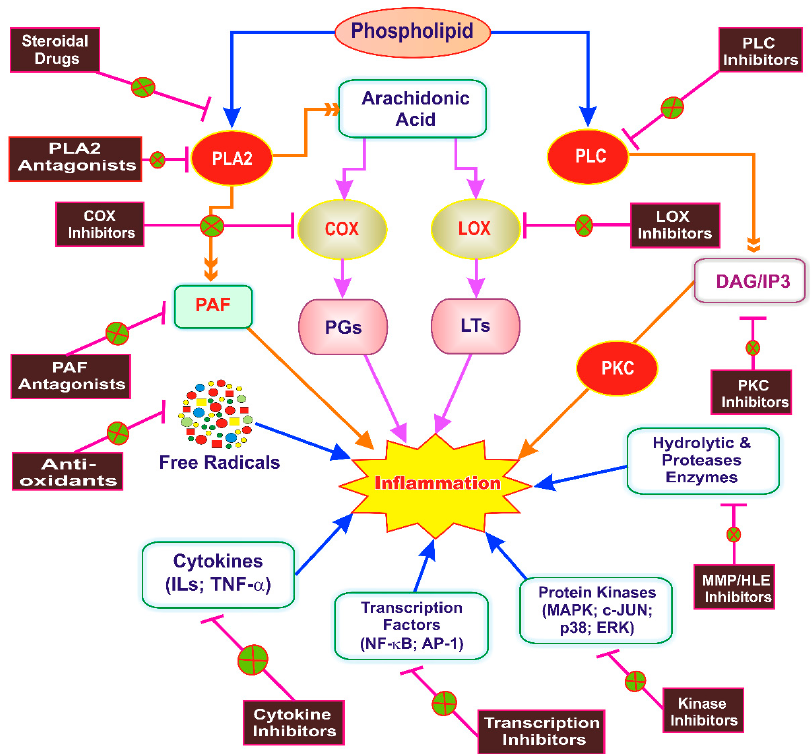
Figure 2. Targets of phytoconstituents in inflammation. PLA2, Phospholipase A2; PLC, Phospholipase C; PKC, Protein kinase C; PAF, Platelet-activating factor; DAG, Diacylglycerol; IP3, Inositol triphosphate; COX, Cyclooxygenase; LOX, Lipoxygenase; PGs, Prostaglandins; LTs, Leukotrienes; MMP, Matrix metalloproteinase; HLE, Human leukocyte elastase; ILs, Interleukins, TNF- α , Tumor necrosis factor-alpha; NF- κ B, Nuclear factor kappa beta; AP-1, Activator protein-1; MAPK, Mitogen-activated protein kinase; P38, P38 kinase; c-JUN, c-Jun N-terminal kinase; ERK, Extracellular signal-regulated kinase. The arrows in the figure represents the process and fork represents inhibition of